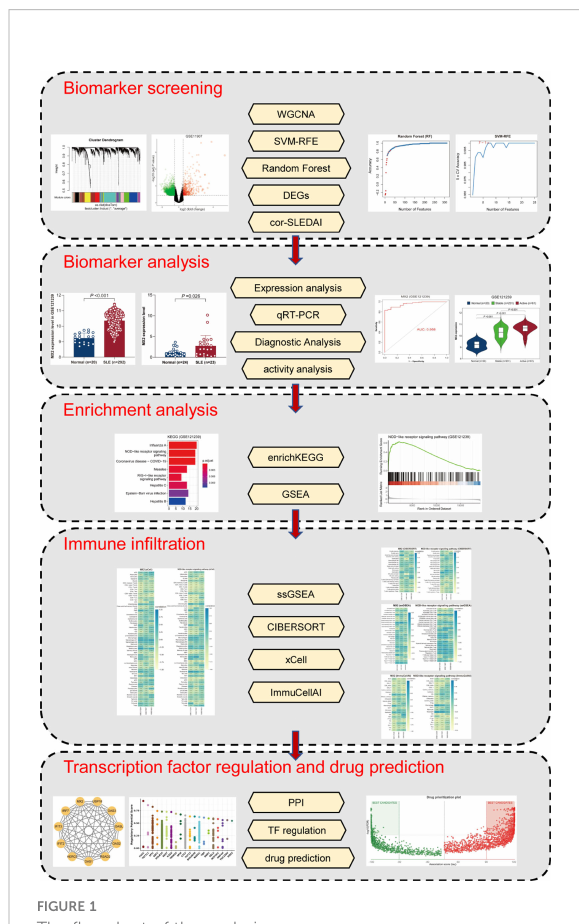
FIGURE 1 The fl owchart of the analysis